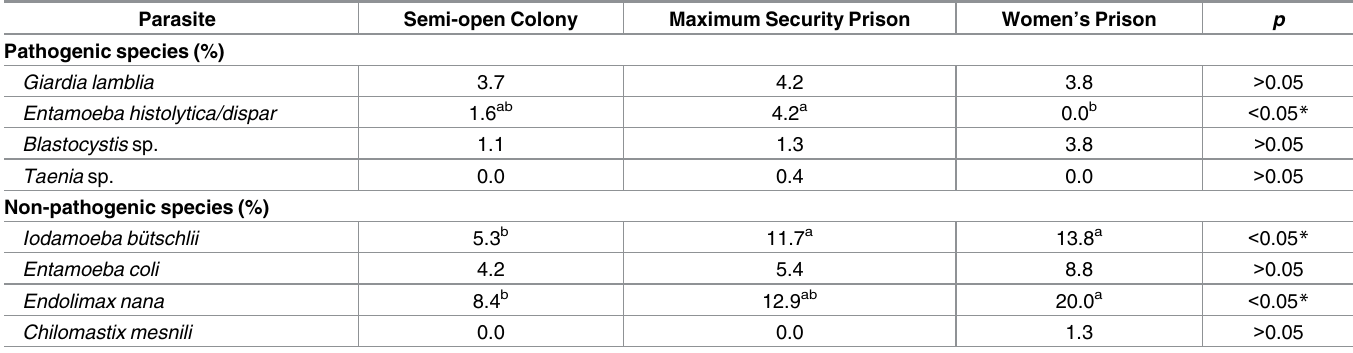
Table 3. Prevalence rates of intestinal parasitesamong inmates serving sentences at three prison facilities in Mato Grosso do Sul, Midwest Brazil (semi-open regime, n = 27; closed-regime Maximum Security, n = 59; closed-regime Women’s Prison, n = 17; total positive cases, n =